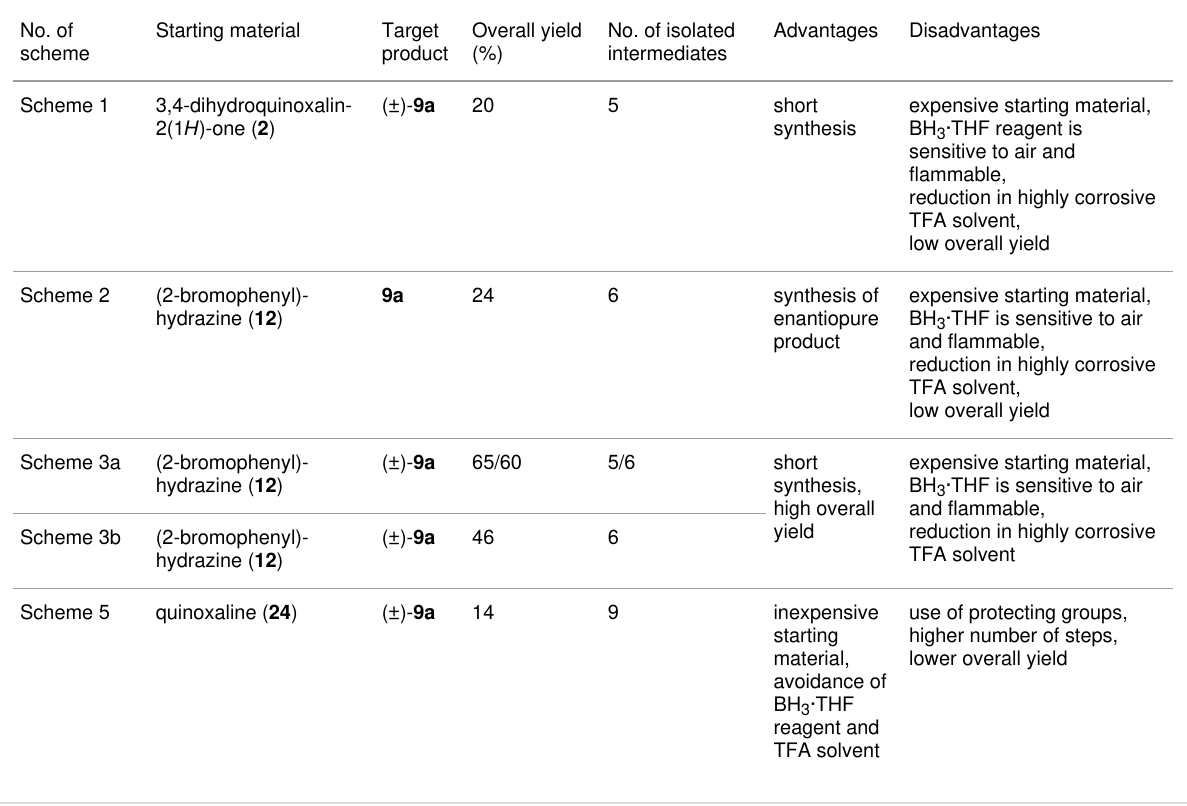
Table 1: Summary of known synthetic methods leading to tetracyclic compound 9a